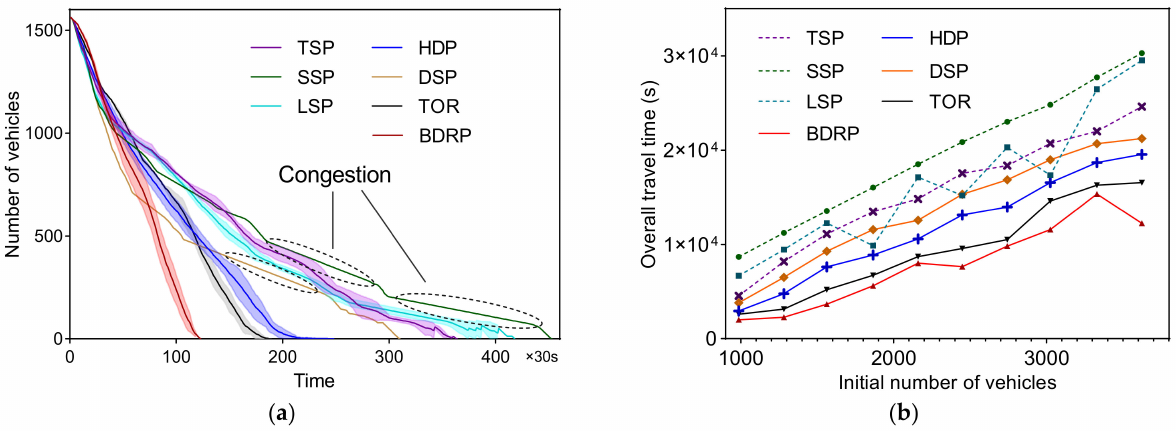
Figure 5. Traffic efficiency comparison between different routing schemes. ( a ) reducing process of remaining vehicles on the road network; ( b ) traffic efficiency under different initial vehicle